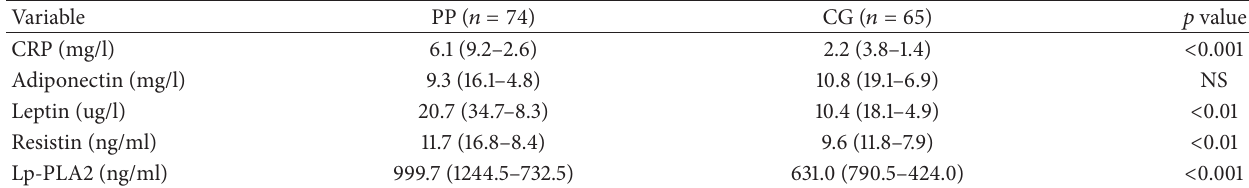
Table 2: Inflammatory markers in the patients (PP) and the controls (CG).